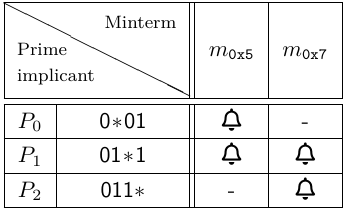
Table 3: Reduced prime implicant chart of f